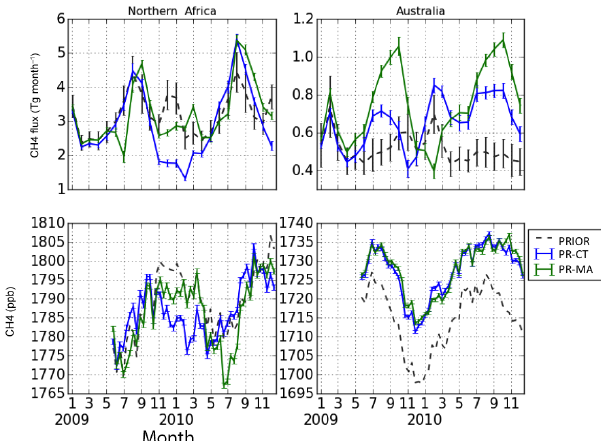
Figure 7. The top panels show the posterior monthly fluxes inte- grated over TransCom region. Bottom panels show the time series of the mean of XCH proxy over northern Africa and Australia. The 4 dotted line in the bottom panels denotes the mean of a priori mod- eled XCH 4 sampled at GOSAT